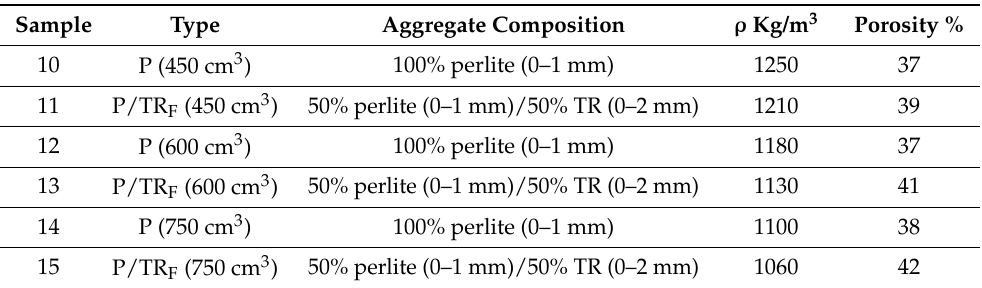
Table 3. Type, aggregate composition, density ρ , and porosity of the expanded perlite and TR